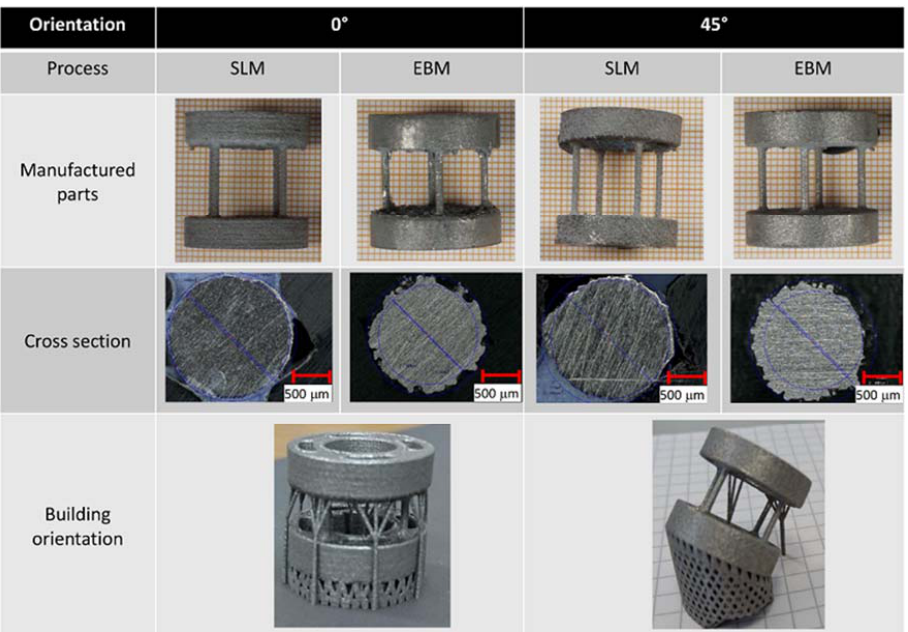
Figure 4. Samples respectively of the parts manufactured in the EBM and SLM process in both orientations—0° and 45°—after removal from the substrate plate and face cutting the top and base area of the test specimen as well as of characteristic cross ‐ sectional areas.